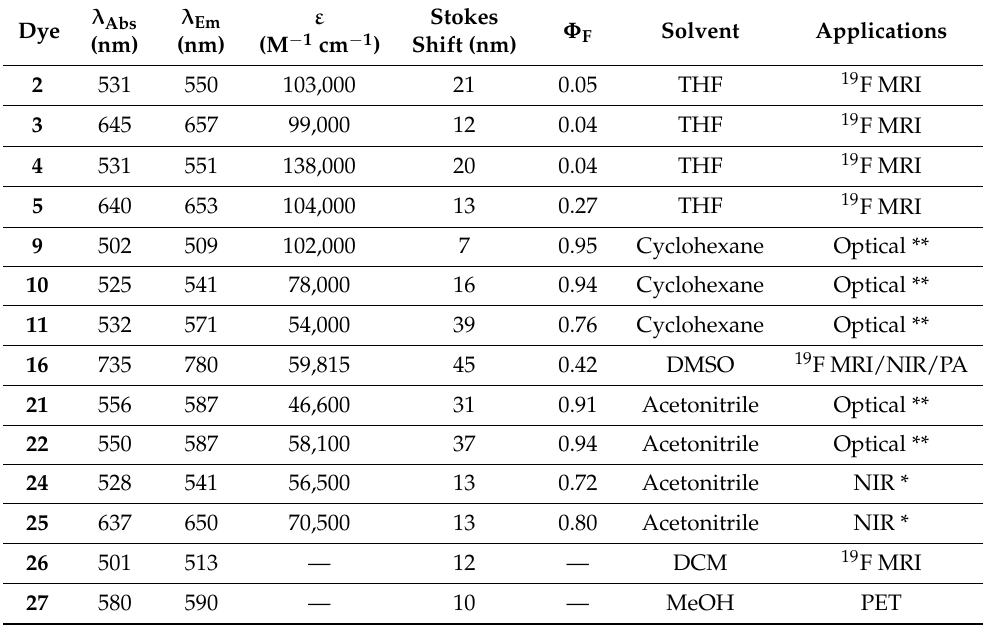
Table 1. Optical properties of selected fluorine containing BODIPY